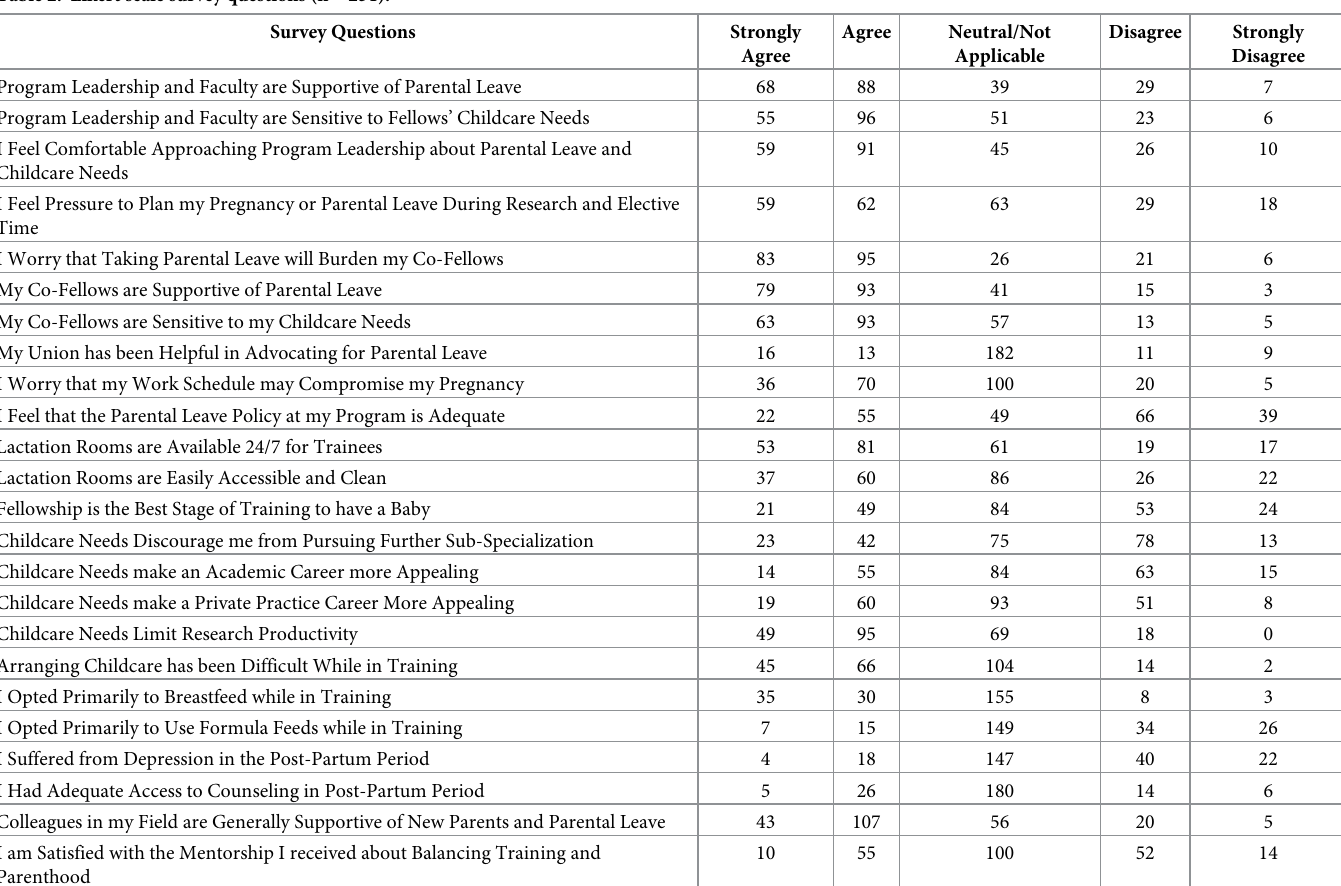
Table 2. Likert scale survey questions (n =